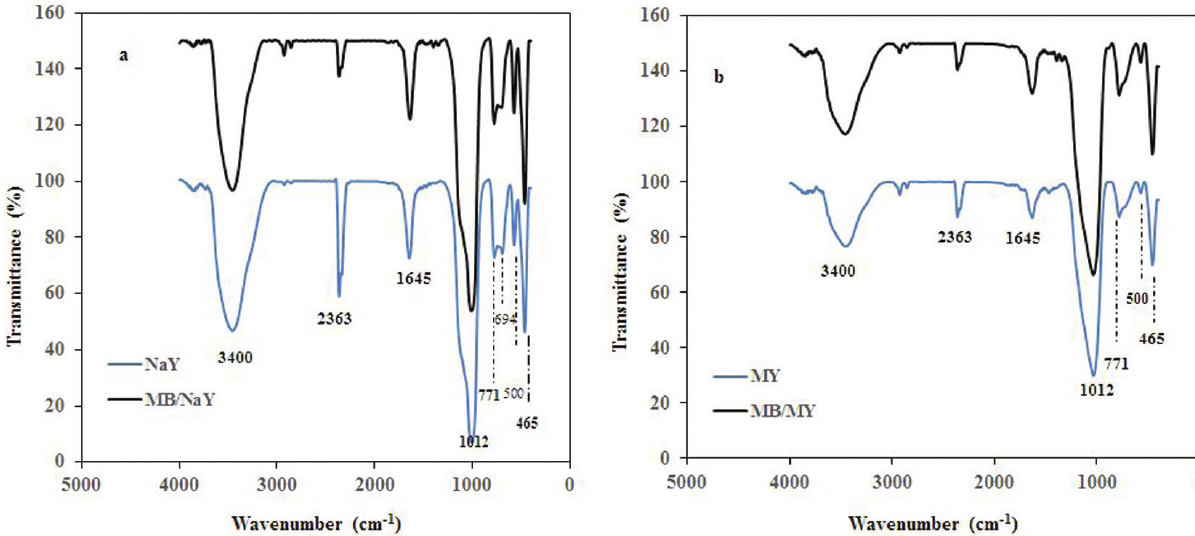
Figure 7: FT-IR spectra of (a) microporous NaY before and after adsorption of methylene blue (MB/NaY) and (b) related FT-IR spectra of hierarchical MY and after adsorption of methylene blue (MB/MY).